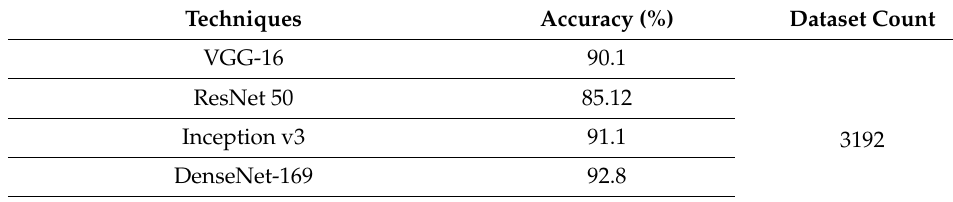
Table 6. Accuracy calculation for detection of monkeypox disease detection.